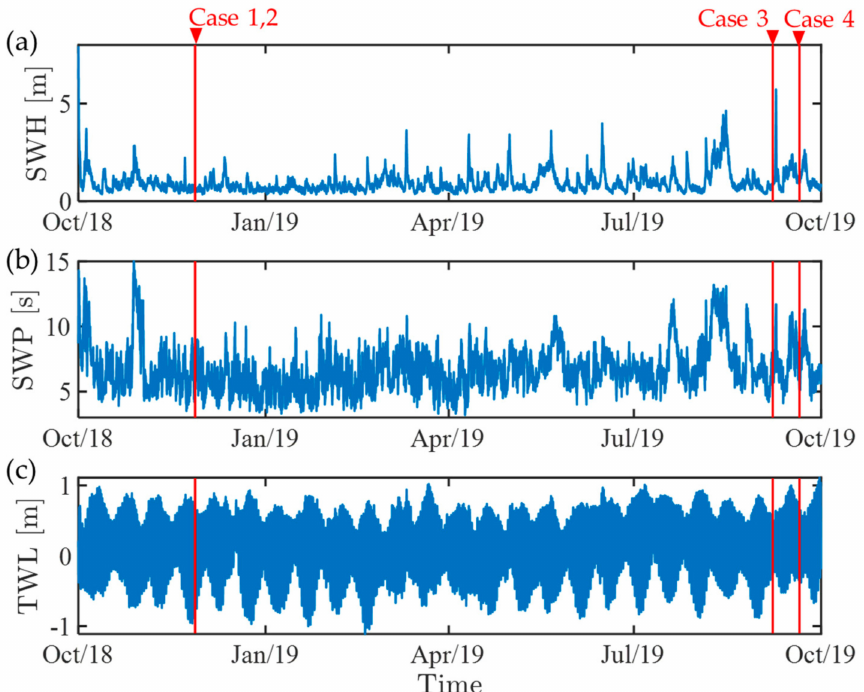
Figure 2. Wave and tide observation data at Omaezaki Station during the test period (October 2018 to September 2019). ( a ) Significant wave height (SWH), ( b ) Significant wave period (SWP) and ( c ) Tidal water level (TWL). The significant wave height and period were obtained from the Nationwide Ocean Wave information network for Ports and Harbors (NOWPHAS), while the tidal water levels were observed by Japan Meteorological Agency (JMA).